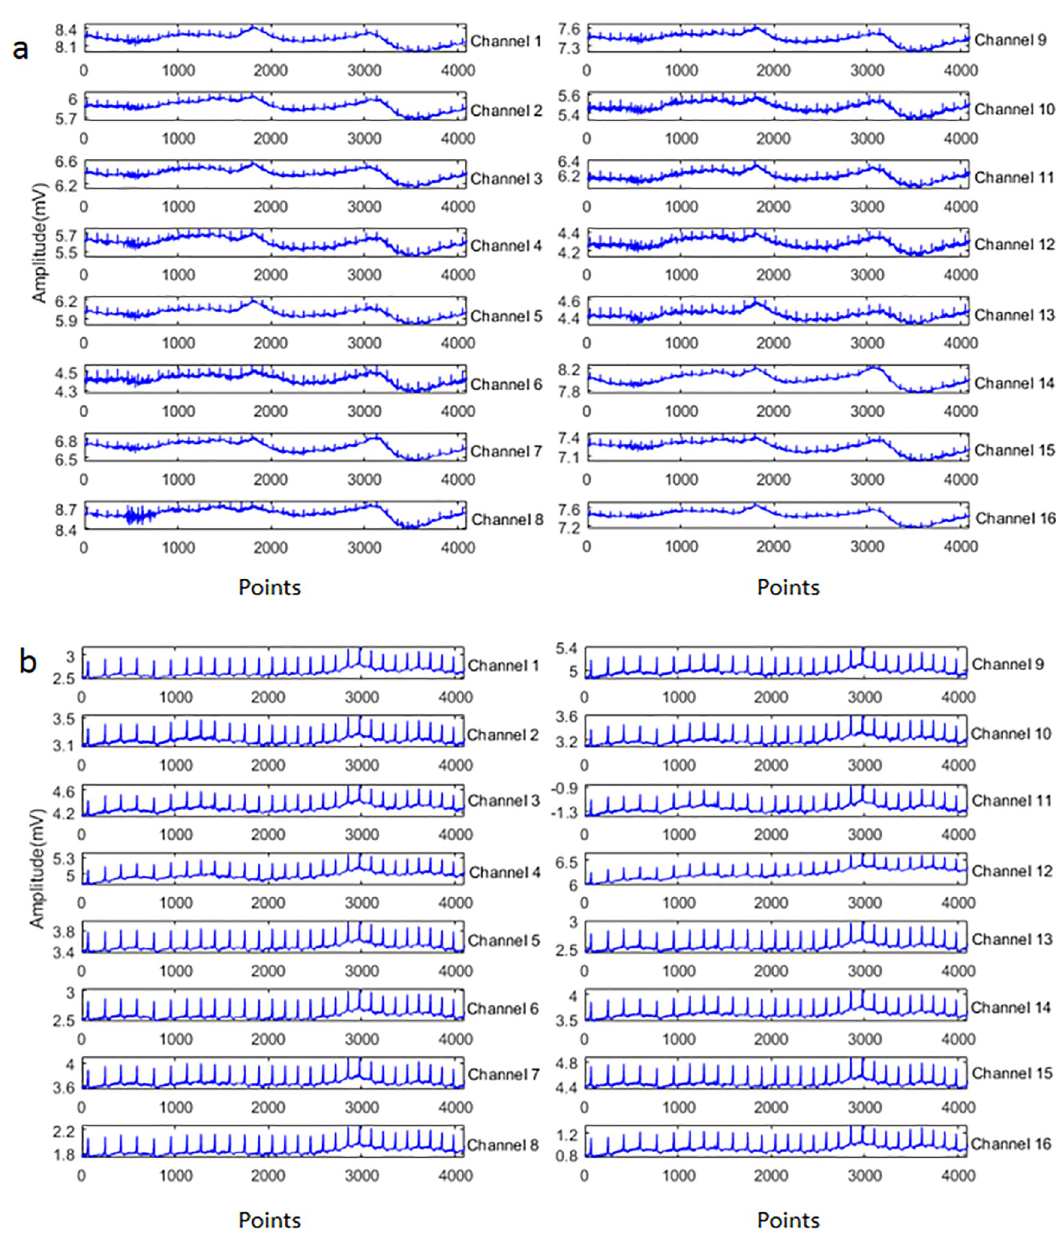
Fig 4. Samples of raw 16-channel EHGs. (a) Pregnancy EHG instance (b) Labor EHG